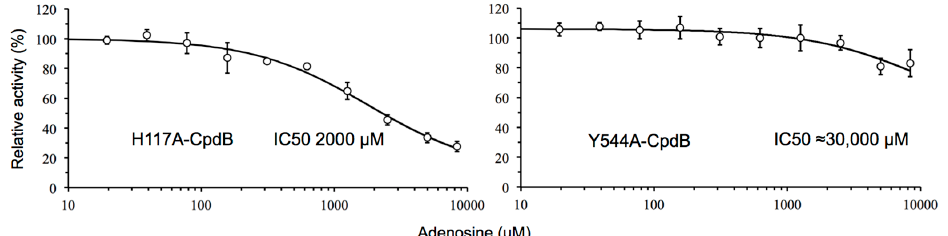
Figure 8. Adenosine dose-response curves of point mutants of CpdB. The curves were recorded with 750 µM bis-4-NPP as the substrate. The data are mean values ± standard deviations of three independent experiments. The curves were obtained by fitting the equation for a mixed partial inhibition to the experimental